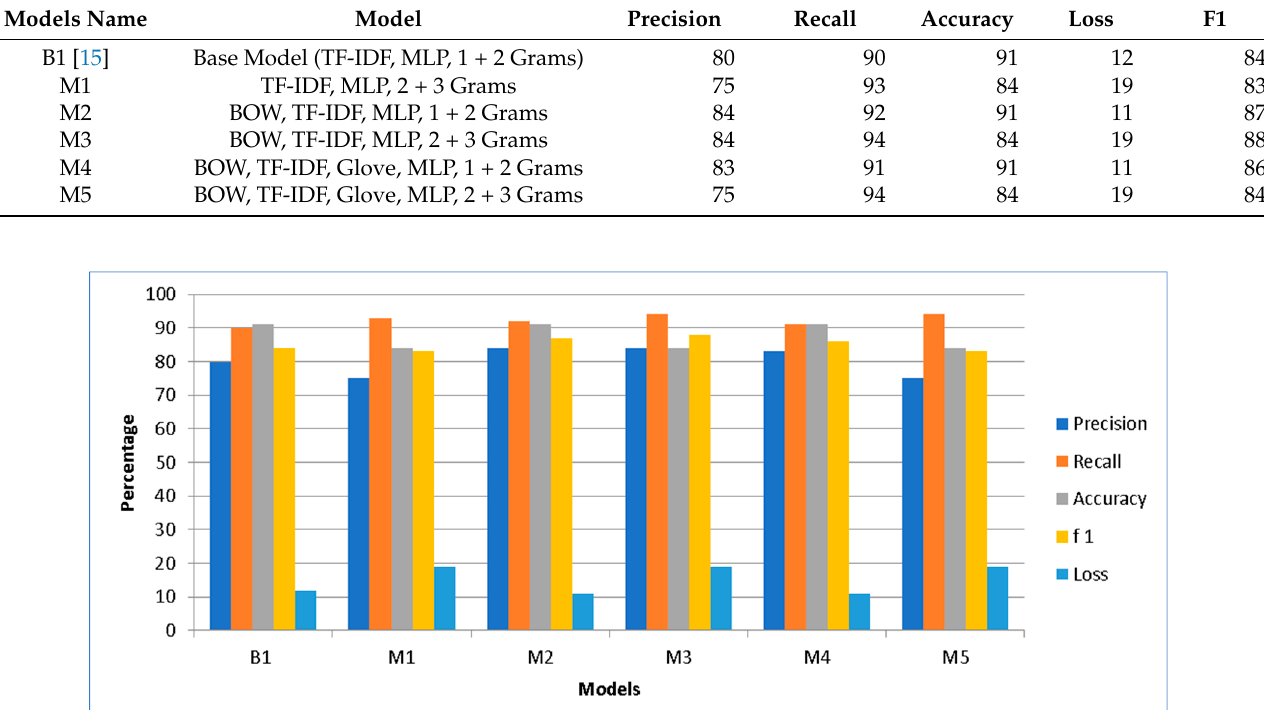
Table 3. Evaluation Table Proposed Model vs. Sadiq, S (2021) Model